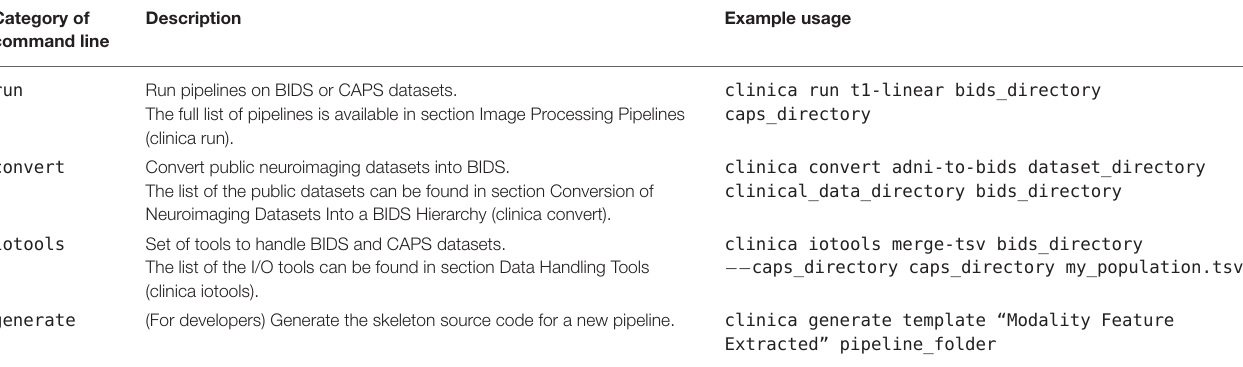
TABLE 1 | Categories of command